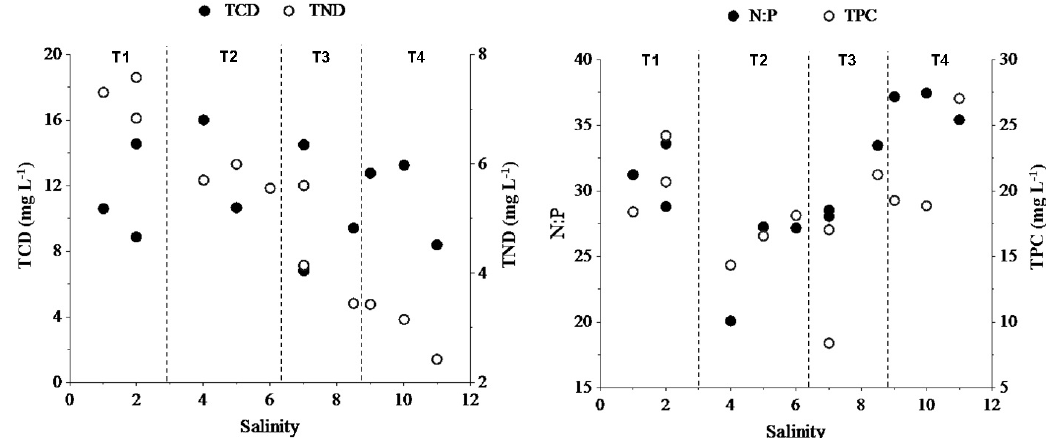
Figure 4. Relationship of dissolved inorganic nutrient: nitrite (NO the relationship between chlorophyll a (Chl-a), carbon content in particulate matter and Suspended Particulate Matter (SPM), at Iguaçu River mouth, Guanabara bay, Rio de Janeiro State, Brazil. T1: transect 1; T2: transect 2; T3: transect 3; T4: transect 4.